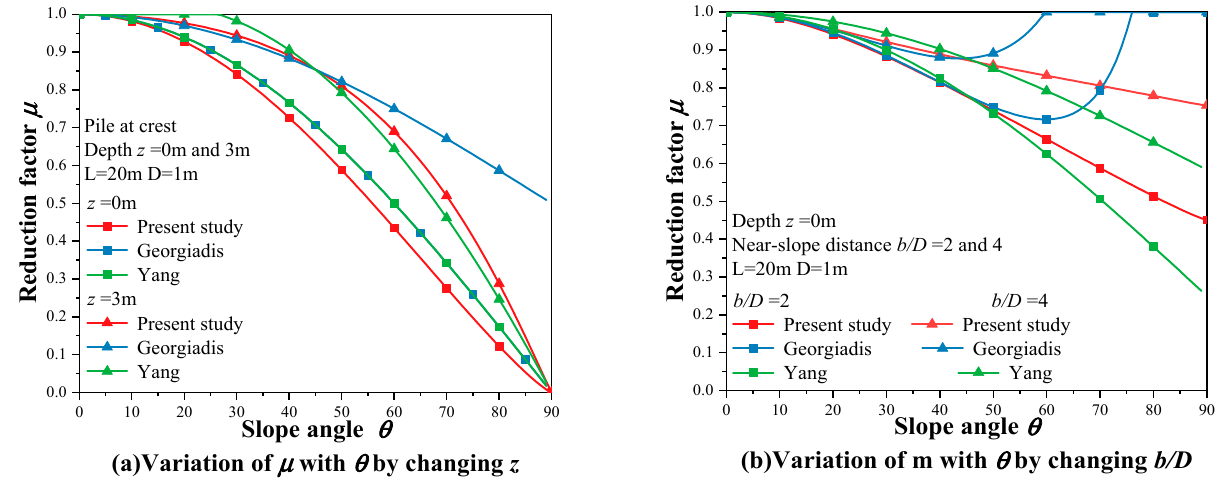
Figure 19. Comparison of the variation of 𝜇 with 𝑧 by changing ( a ) 𝜃 and ( b ) 𝑏/𝐷 [16,18].